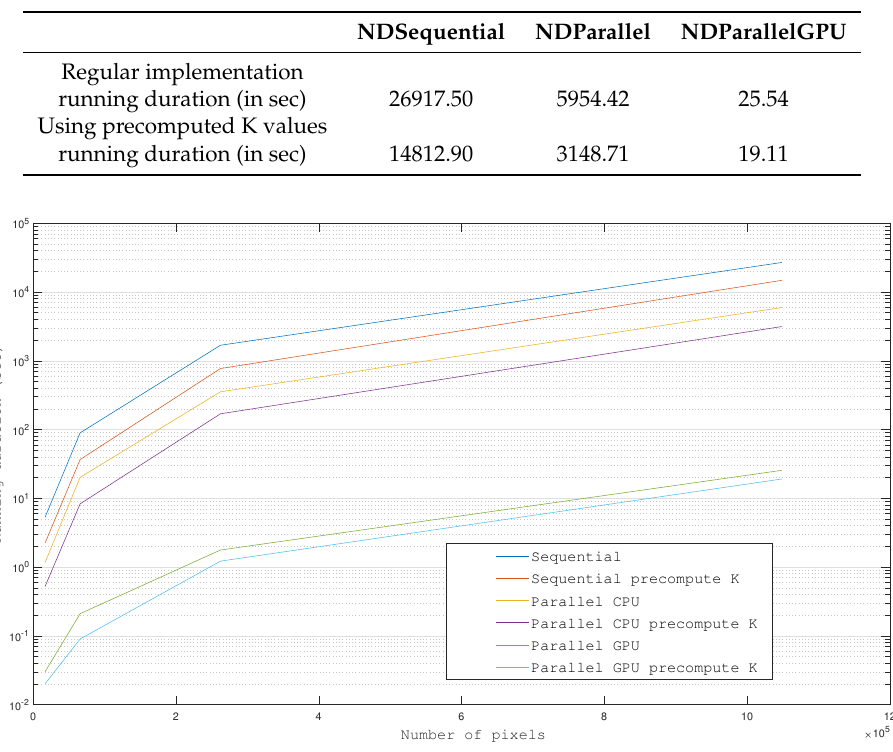
Table 4. Time comparison for the three diffusion algorithm types running on a 1024 × 1024 image.